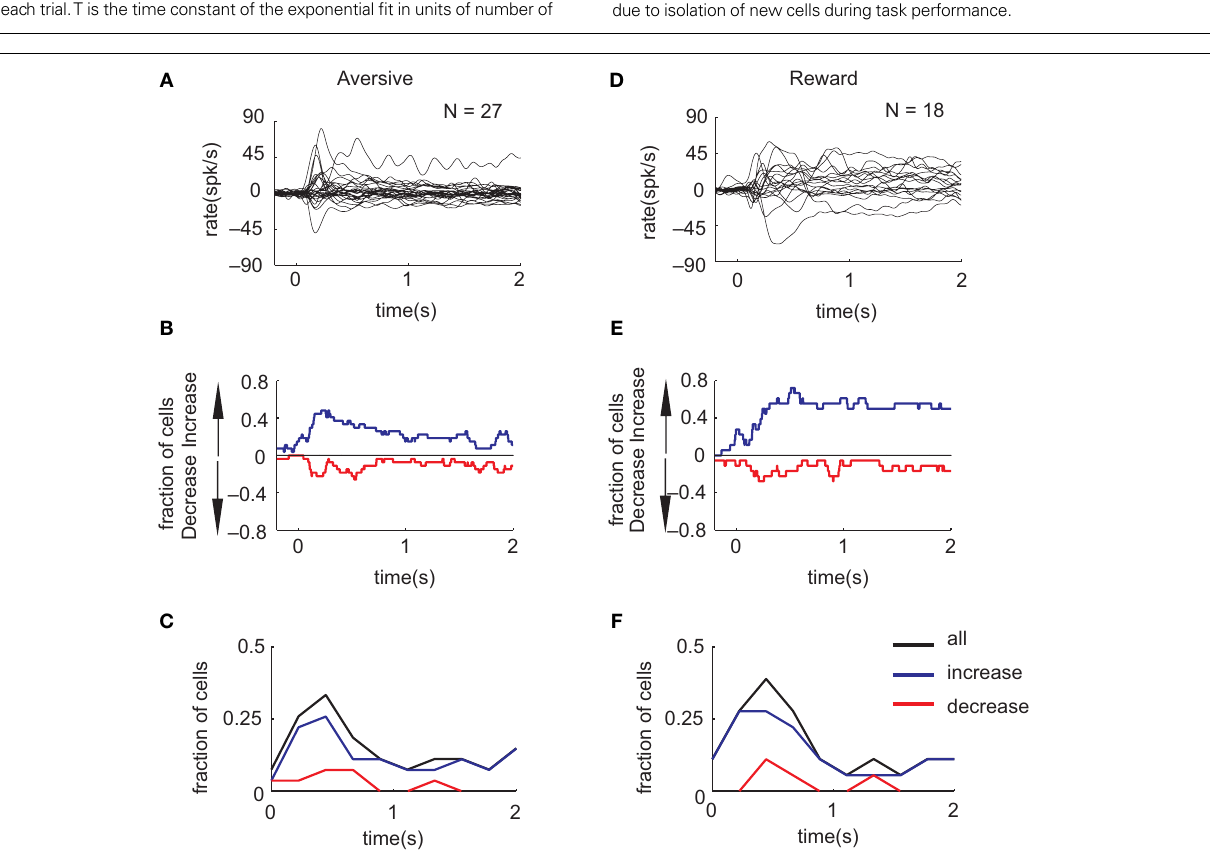
in their discharge rate in response to the new cue after saturation of behavioral learning. (C) The temporal pattern of SNpr encoding of new cues. The fraction of cells in which the response to the new aversive cue was signifi cantly different than the response to familiar aversive events as a function of the time after cue presentation in bins of 200 ms. Black – all responses, blue/red – responses with increase/decrease of discharge rate. (D–F) Same as (A–C) for the familiar and new cues predicting reward outcome.